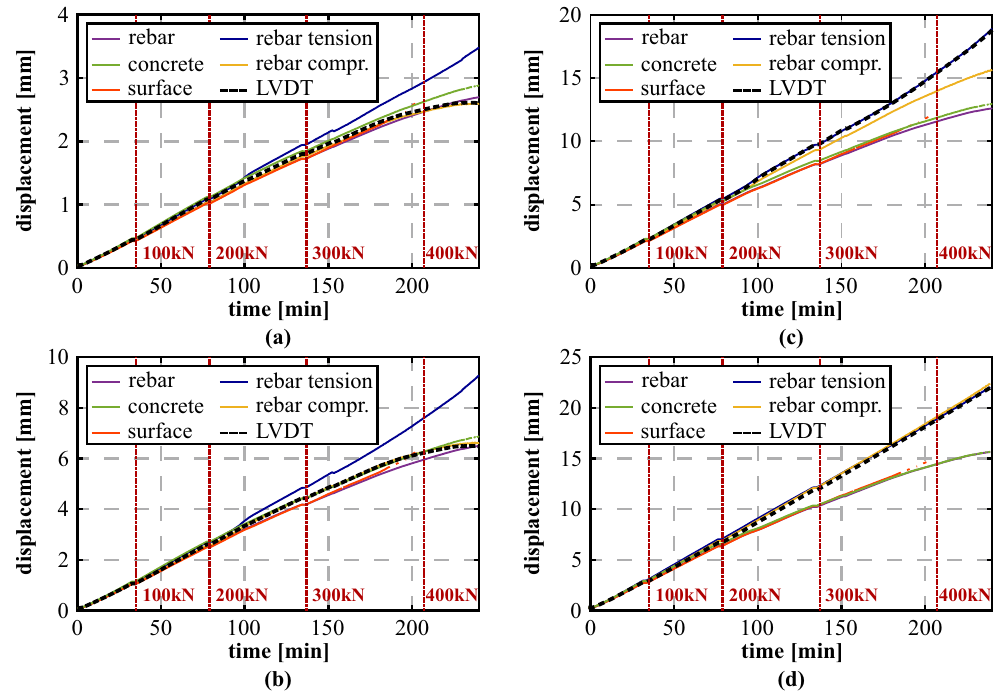
Figure 12. Comparison between DFOS and LVDT displacements over time: ( a ) LVDT #06 (+1.65 m). ( b ) LVDT #05 (+1.35 m). ( c ) LVDT #03 (+0.75 m). ( d ) LVDT #02 (0.00